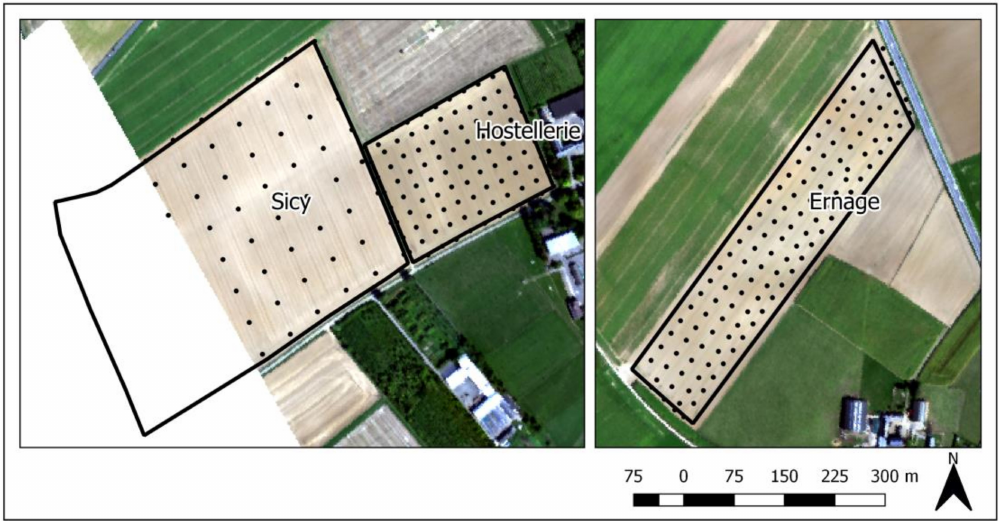
Figure 2. RGB image of the Sicy, Hostellerie and Ernage fields in the Belgian loam belt acquired by the hyperspectral Airborne Prism Experiment (APEX) sensor on 02 September 2018 (red: 616 nm, green: 551 nm, blue: 470 nm) and the locations of the soil